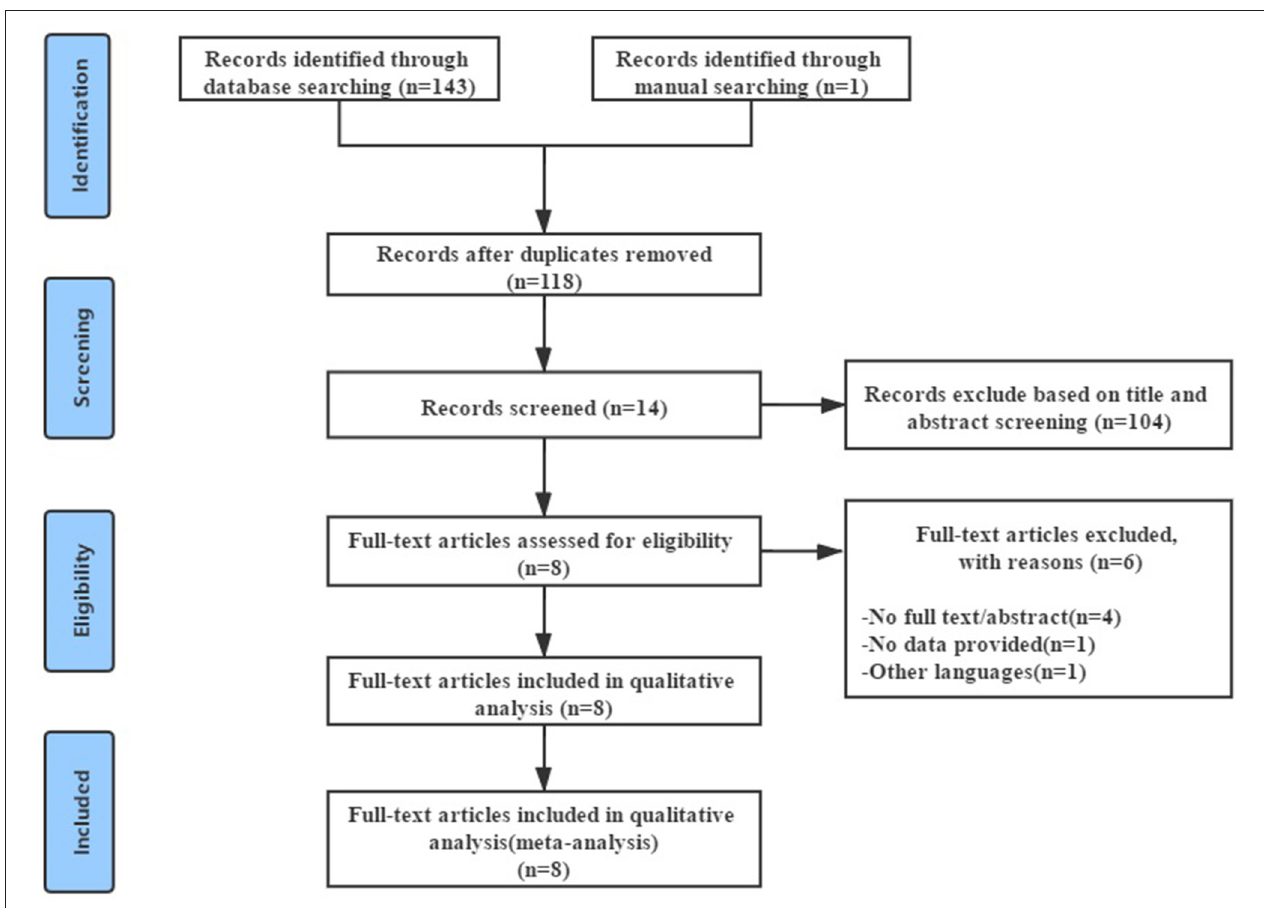
FIGURE 1 | Flowchart of meta-analysis search and selection